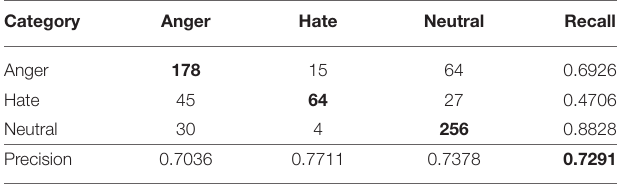
TABLE 13 | Confusion matrix for the fasttext classifier for the facebook